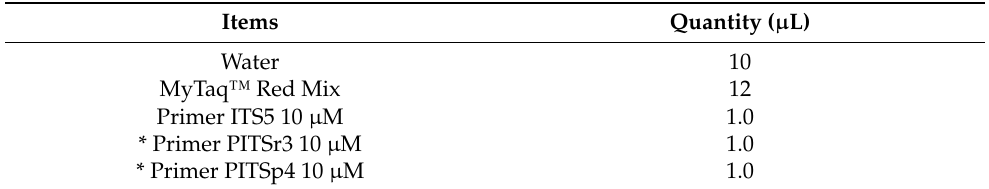
Table 4. Master mix of specific PCRs for both PCN species identification in one reaction (multi- plex PCR).